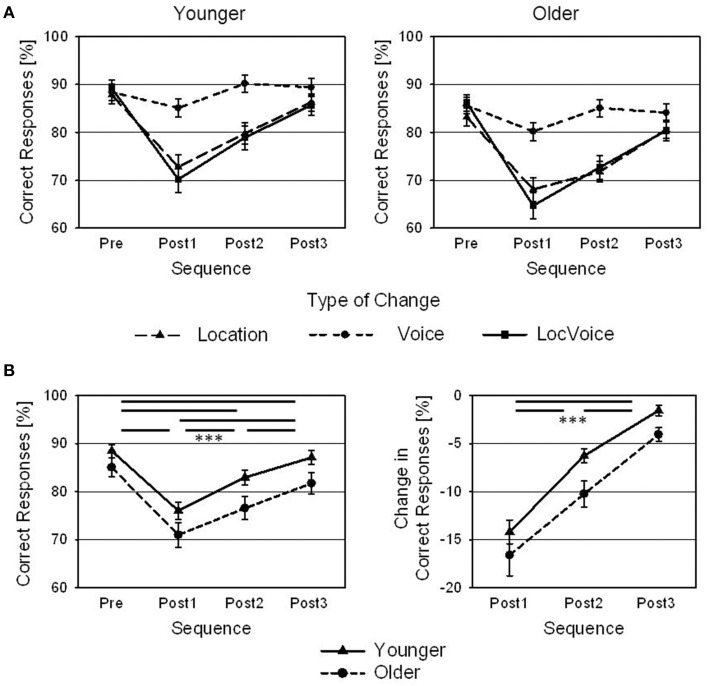
Behavioral results. (A) Rates of correct responses of younger and older adults for Pre, Post1, Post2, and Post3 sequences, and for changes in target speaker location, voice, and combined changes in location and voice (LocVoice). (B) Rates of correct responses (left panel) and changes in the rate of correct responses (same data normalized with reference to pre-change levels; right panel) of younger and older adults, averaged across all types of changes, shown for Pre, Post1, Post2, and Post3 sequences. Error bars are standard errors across participants (N = 22; ***p < 0.001).